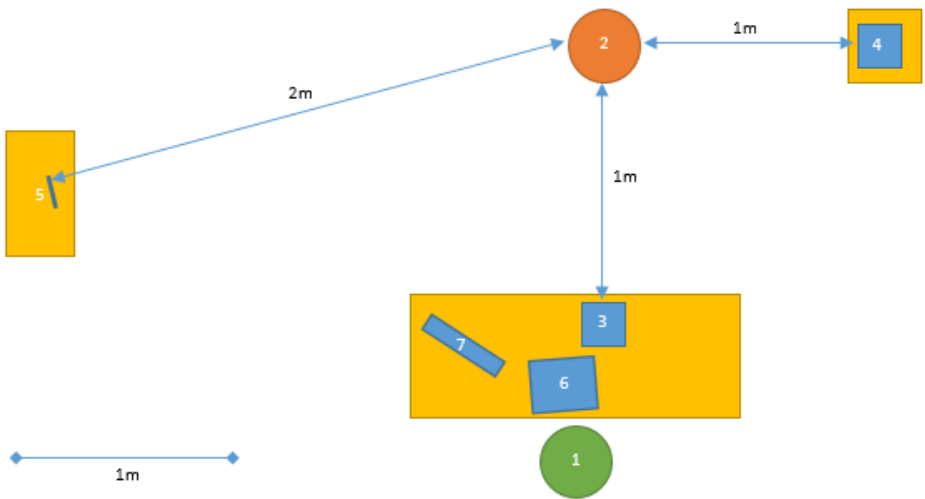
Figure 2. Experiment set-up: 1—Researcher; 2—Participant; 3,4—Speakers; 5—Video